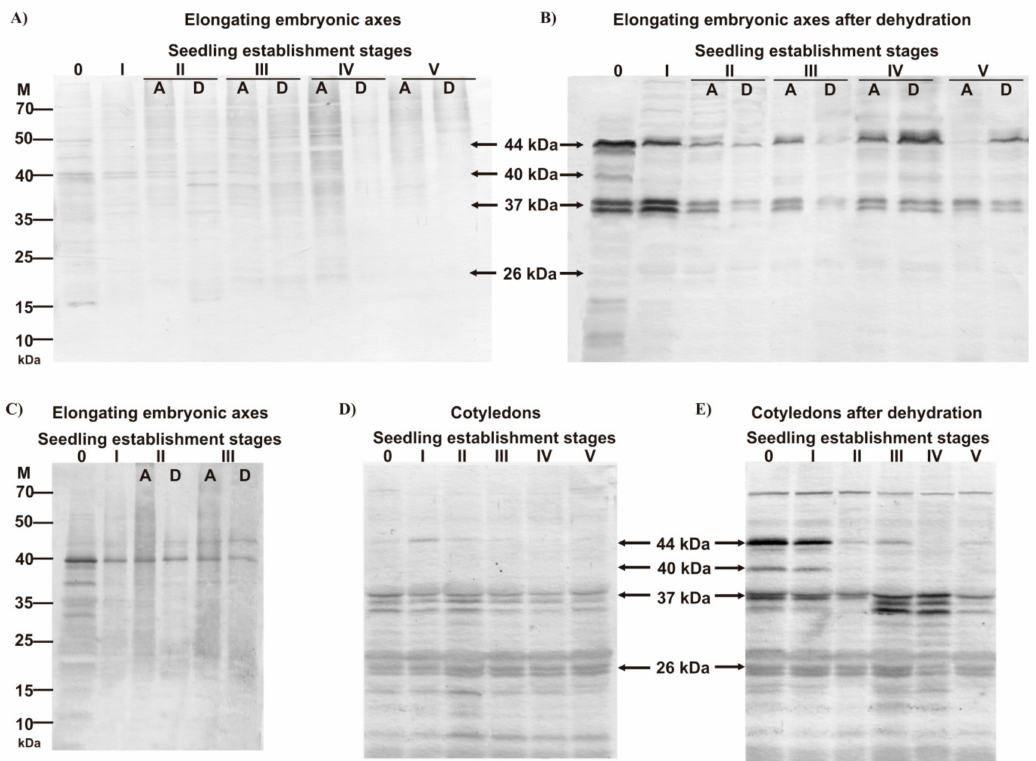
Figure 4. Detection of dehydrin-like proteins (indicated as arrows) in the elongating embryonic axes ( A – C ) and cotyledons ( D – E ) of germinated seeds and at early seedling establishment stages of Fagus sylvatica by Western blotting with antibodies specific to the K-segment before ( A , D ) and after dehydration to 11% of water content ( B , E ). Soluble ( A , B , D , E ) and heat-stable ( C ) protein extracts of 12.5 µ g and 30 µ g, respectively, were used. Each image is representative of three